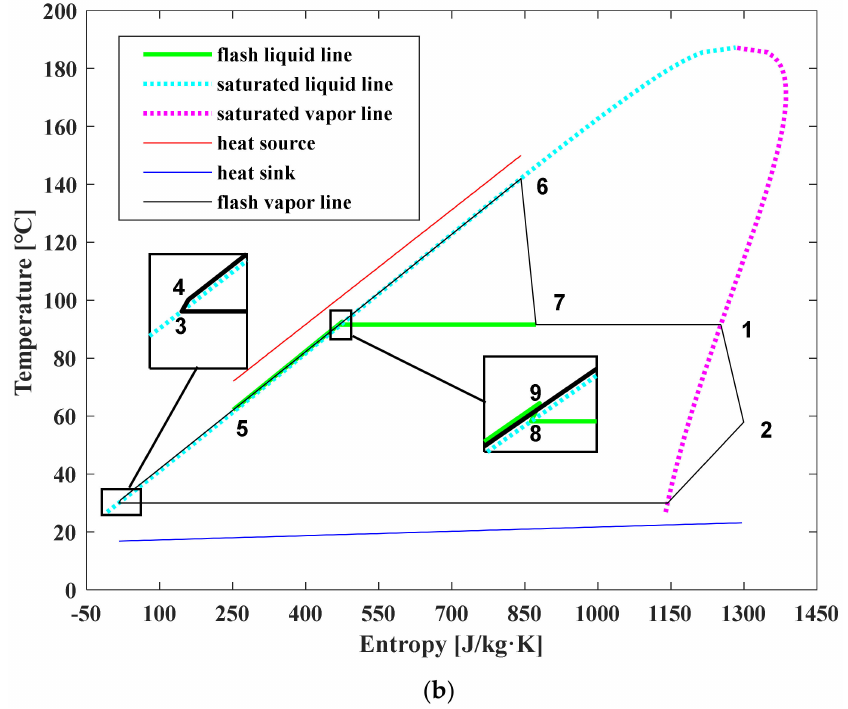
Figure 1. Schematic diagram of the ROFC-based CHP system: ( a ) system layout; ( b ) temperature– entropy diagram. Table 1. Parameters of monthly temperature and heat demand in Daegu, South